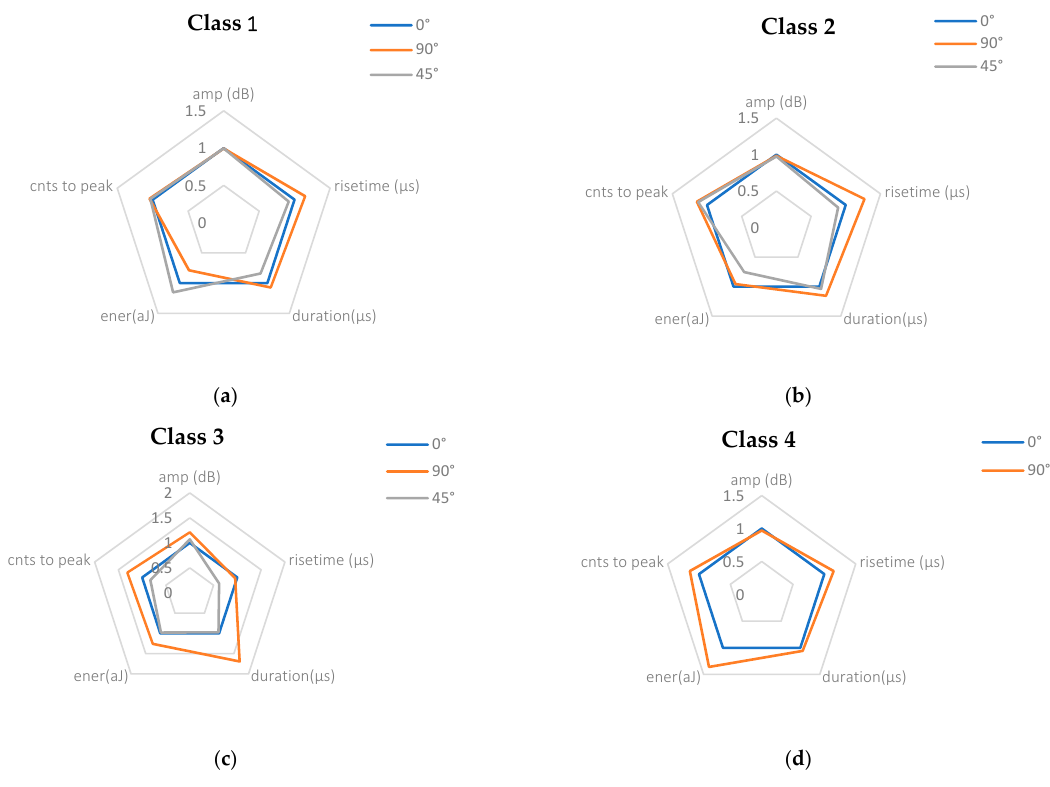
Figure 16. Average characteristics of the different identified classes.